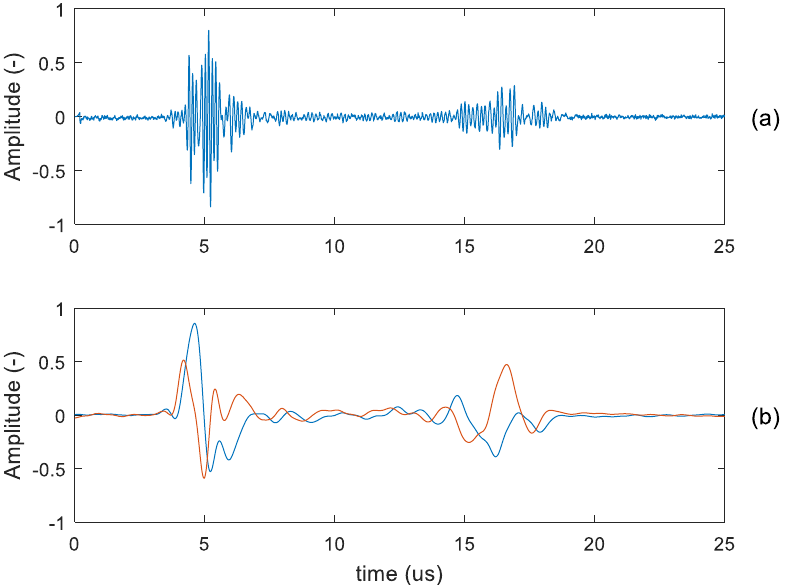
Figure 1. Raw signal ( a ) and I/Q demodulated signal ( b ) acquired from a fluid flowing in an 8 mm diameter pipe investigated with 6 MHz bursts. The strong echoes visible at 5 µs and 16 us are the reflections of the pipe walls; the useful signal of the moving fluid is barely visible in-between the pipe echoes.